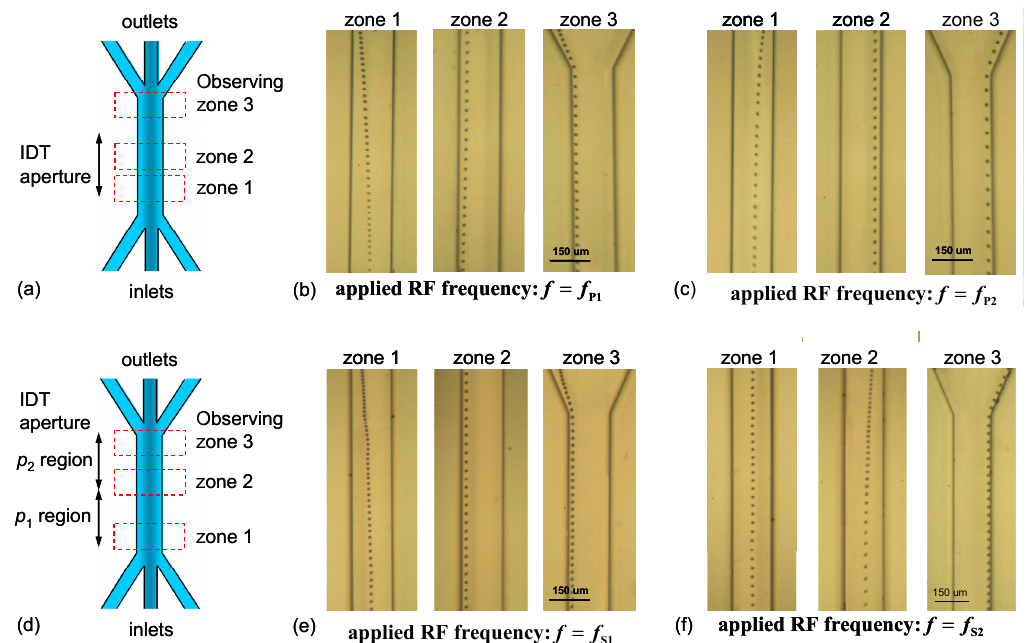
Figure 9. Schematic of the SSAWs working range covered by the ( a ) parallel and ( d ) series IDT apertures and three observing zones along the microfluidic channel. Stacked trajectories of a particle driven by the dual-wavelength SSAWs excited by the parallel IDTs at input frequencies ( b ) f P 1 and ( c ) f P 2 and by the series IDTs at input frequencies ( e ) f S 1 and ( f ) f S 2 . Although increasing the input power does not change the ARF distribution in the model on the along the x direction of the particle. To validate this effect experimentally, we varied the input RF power and observed the variation of the lateral displacement for the two-pitch IDT designs; the